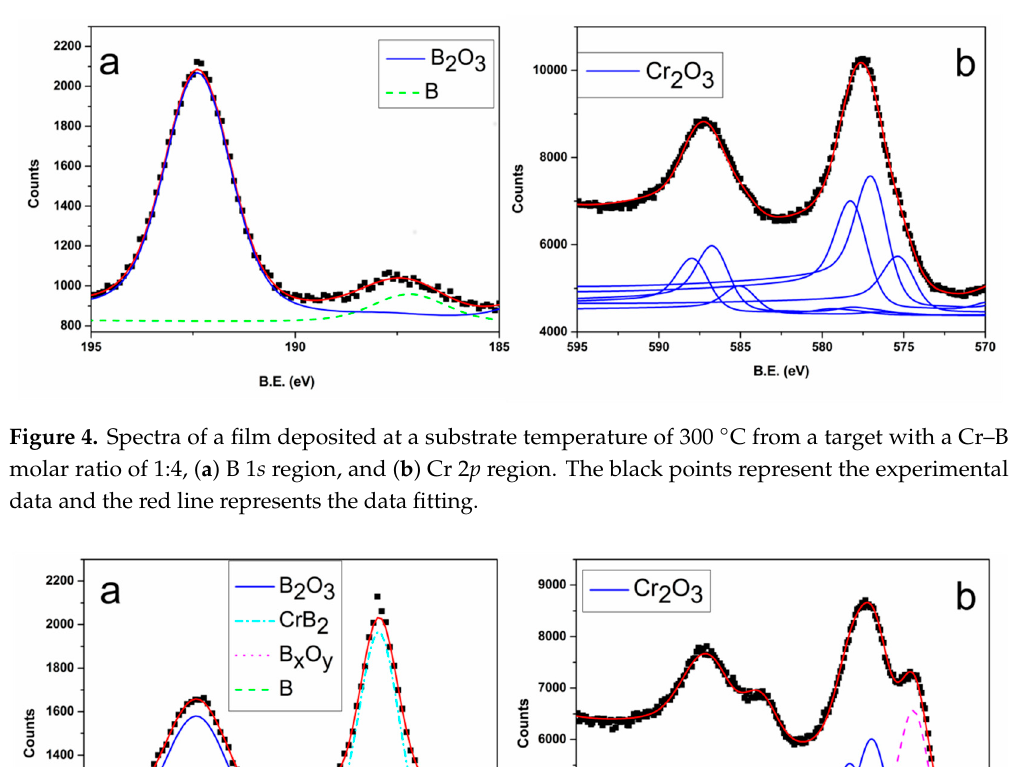
Figure 3. XPS spectra of a film deposited at a substrate temperature of 25 ◦ C from a target with a Cr-B molar ratio of 1:4, ( a ) B 1 s region, and ( b ) Cr 2 p region. The black points represent the experimental data and the red line represents the data fitting.